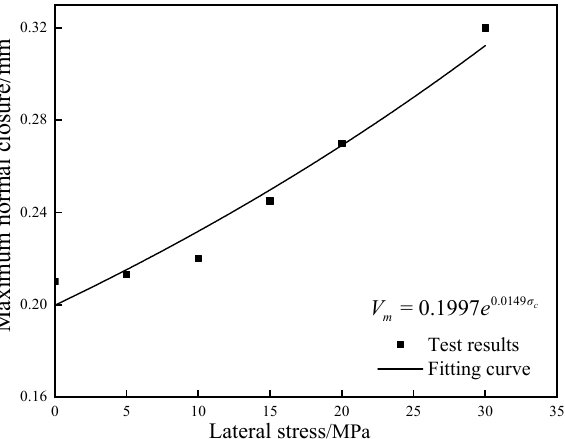
Figure 13. Comparison of the test and fitting results of the relationship between maximum normal closure and lateral stress.